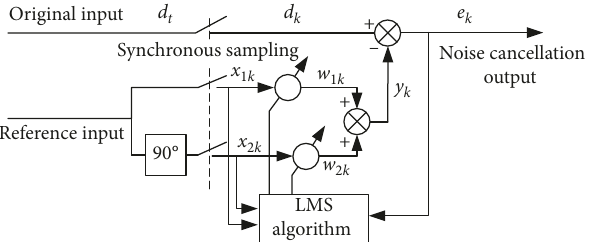
Figure 3: Single frequency adaptive notch